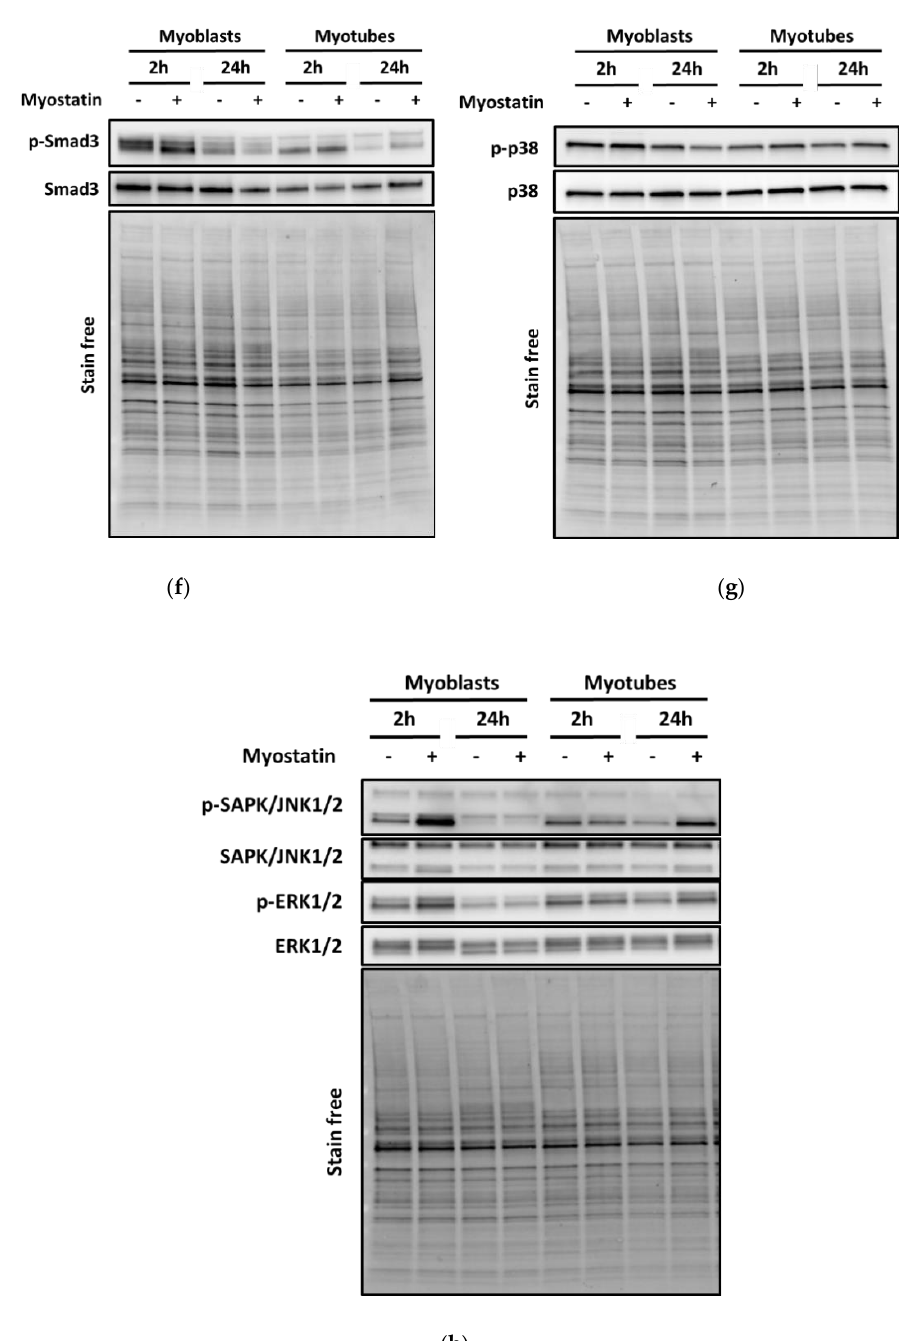
Figure 7. Myostatin-induced changes in the canonical (Smad3) and noncanonical (MAPKs) pathways were similar in CHQ myoblasts and myotubes . ( a ) Phosphorylated Smad3 Ser423 / 425 and total Smad3 in myoblasts and myotubes. ( b ) Phosphorylated p38 Thr180 / Tyr182 and total p38 in myoblasts and myotubes. ( c ) Phosphorylated SAPK / JNK1 / 2 Thr183 / Tyr185 and total SAPK / JNK1 / 2 in myoblasts and myotubes. ( d ) Phosphorylated ERK1 / 2 Thr202 / Tyr204 and total ERK1 / 2 in myoblasts and myotubes. In the figures, the values are presented as normalized to CTRL = 1. ( e ) Nontreated CTRL myoblasts and myotubes of the 2-h and 24-h time-points were pooled and the values are presented as normalized to myoblasts = 1. ( f – h ) Representative blots. N = 6 per group. *, **, and *** = p < 0.05, p < 0.01, and p > 0.001, respectively. CTRL (-) = control group, MSTN ( + ) = myostatin group.